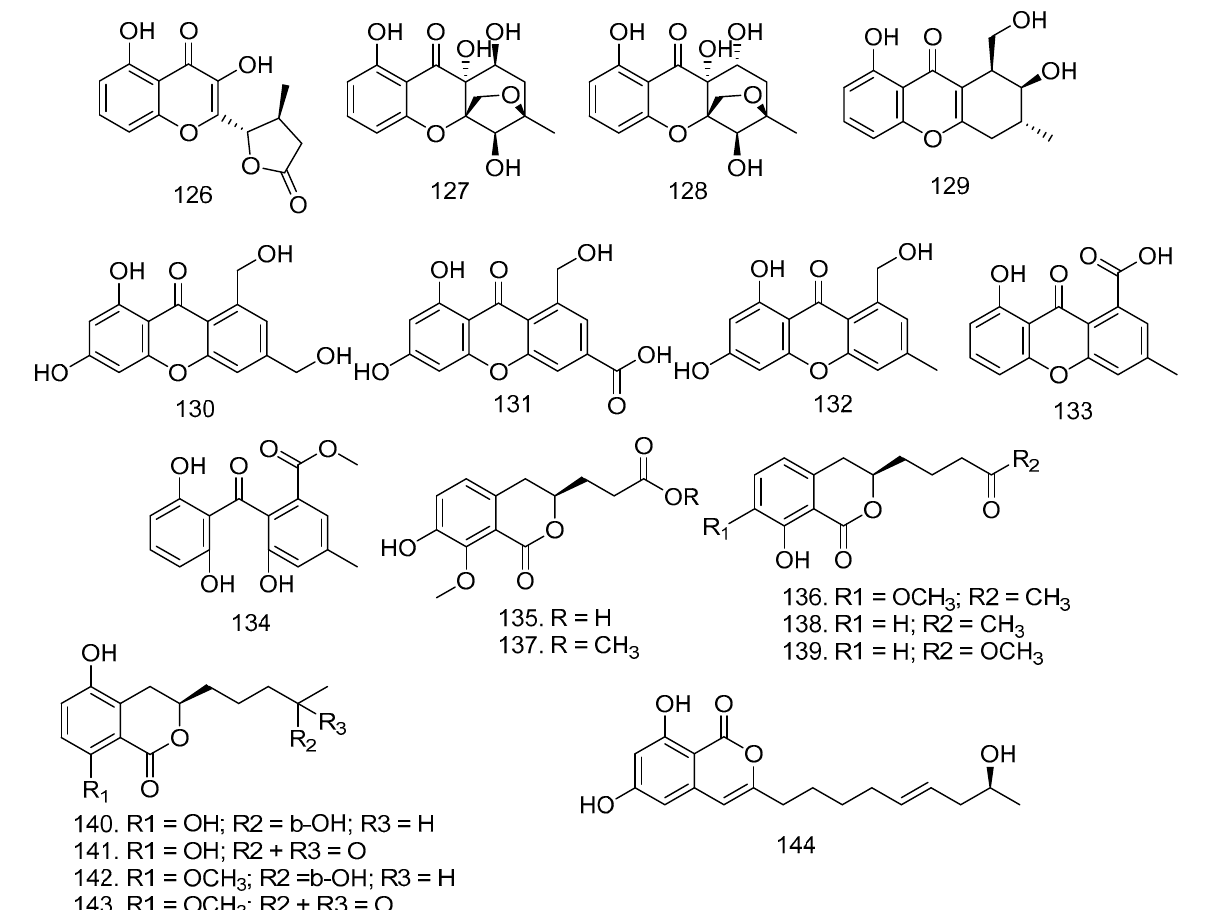
Figure 7. Xanthones ( 126 – 134 ) and isocoumarins ( 135 – 144 ), isolated from Meliaceae-derived fungi.